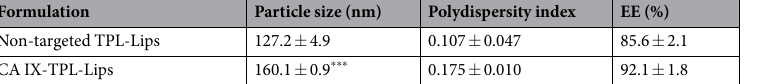
Table 1. Characterization of liposomal TPL. Note: *** p < 0.001 when compared with the non-targeted TPL- Lips